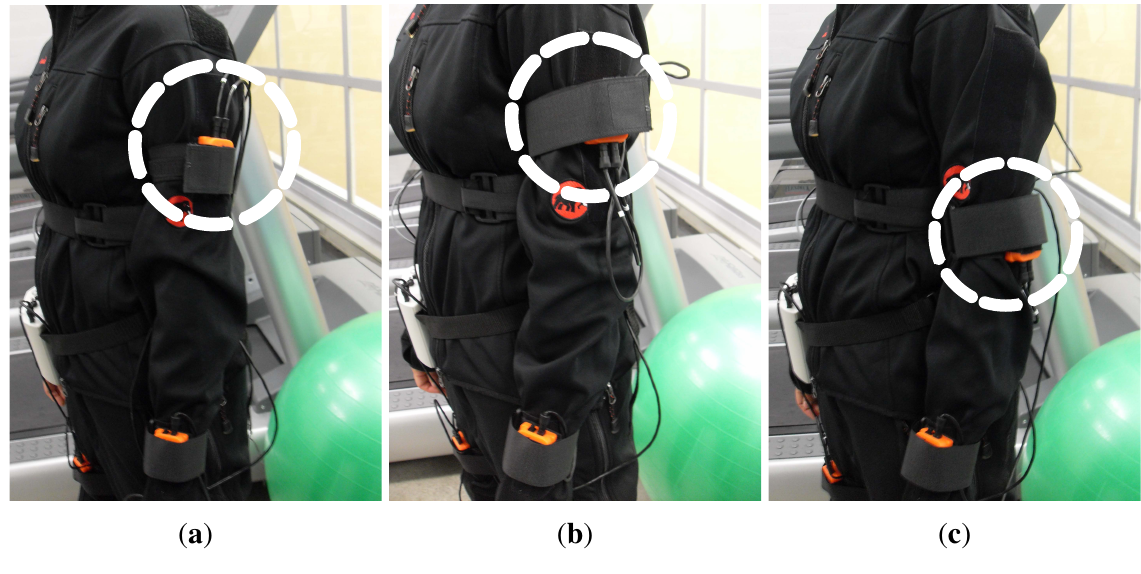
Example of possible sensor placements according to the ( a ) ideal, ( b ) self-placement and ( c ) induced-displacement deployments. In ( b ), the sensor is arbitrarily rotated 180 ◦ (approximately) by the user with respect to the ideal positioning ( a ). In ( c ), the expert explicitly displaces the sensor from the middle upper arm to the